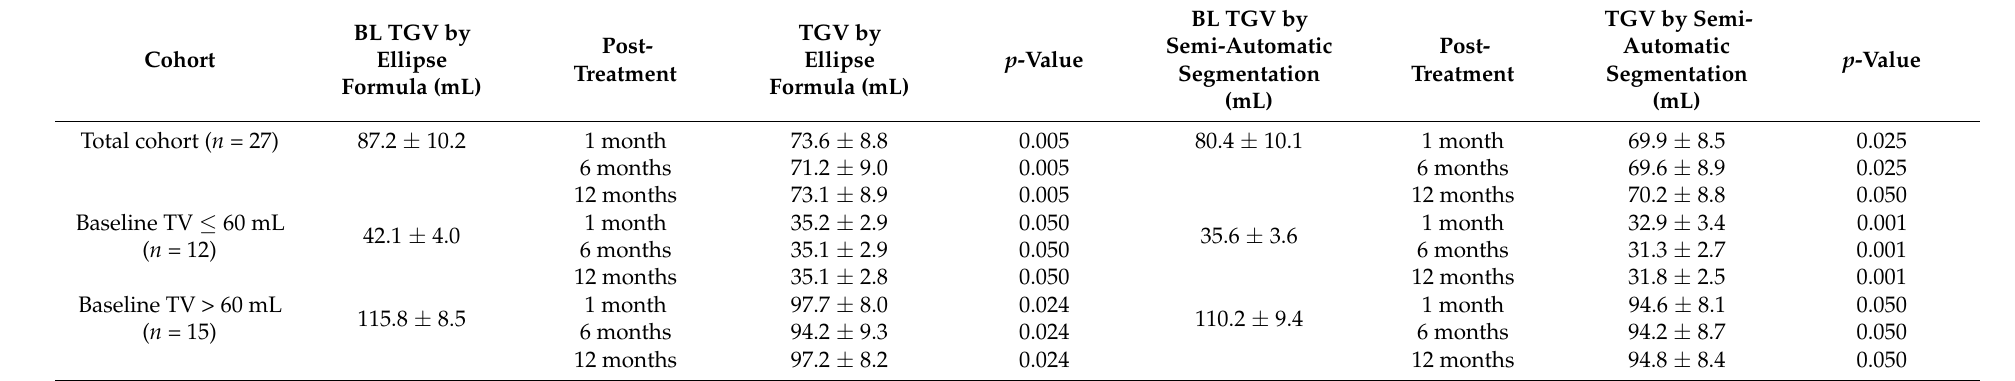
Table 3. Pre- and post-treatment TGV using ellipse formula and semi-automatic segmentation method. Values presented as means ± SD. P -values include Bonferroni multiple testing correction.